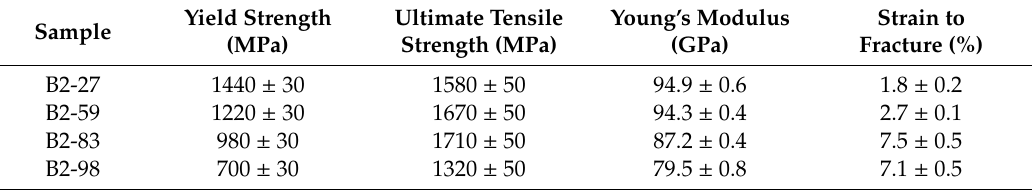
Table 2. Mechanical properties of the Cu 10 Zr 7 dendrite / B2 nano- and microcomposites obtained